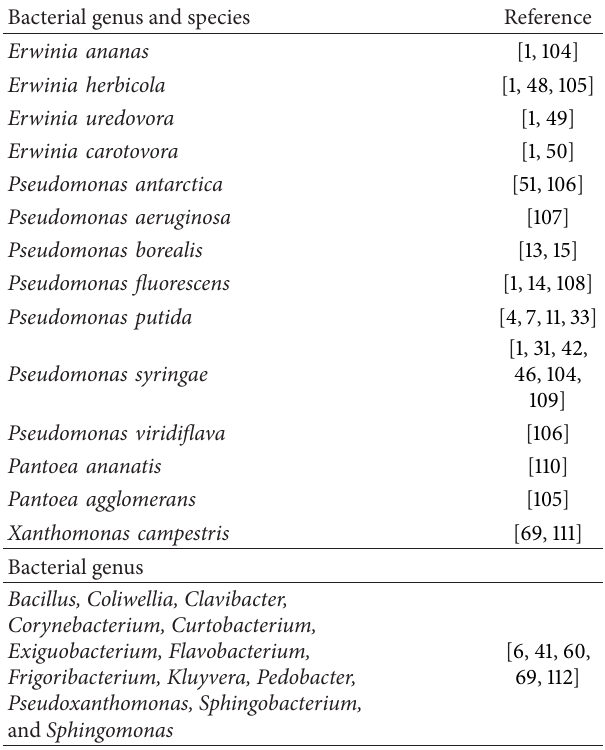
Table 1: Documented ice nucleation active